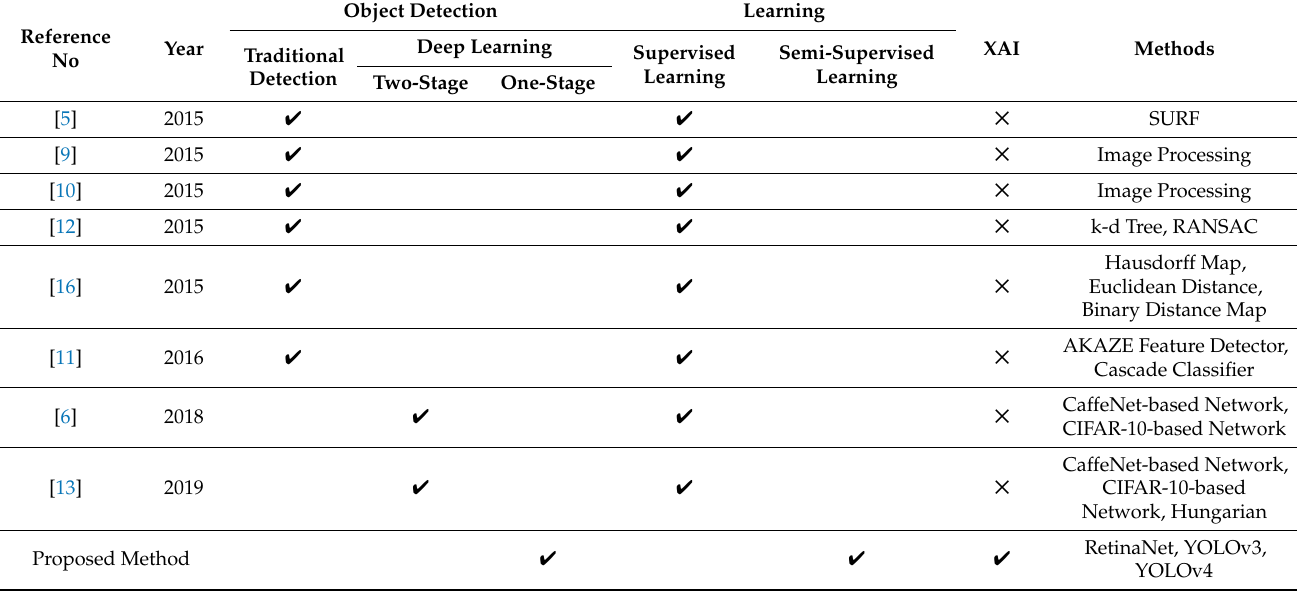
Table 1. Comparison of the proposed Semi-Supervised Learning on on-shelf availability (SOSA) approach and the previous